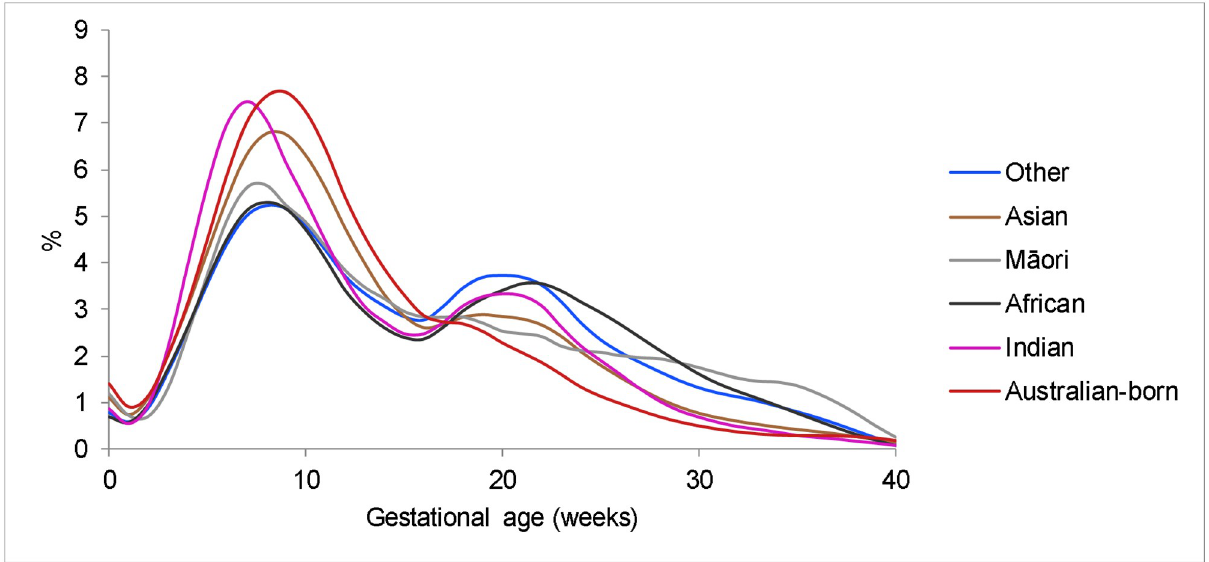
Fig 2. Distribution of gestational age at first ANC visit for specified study groups (2010–2013). ANC, antenatal